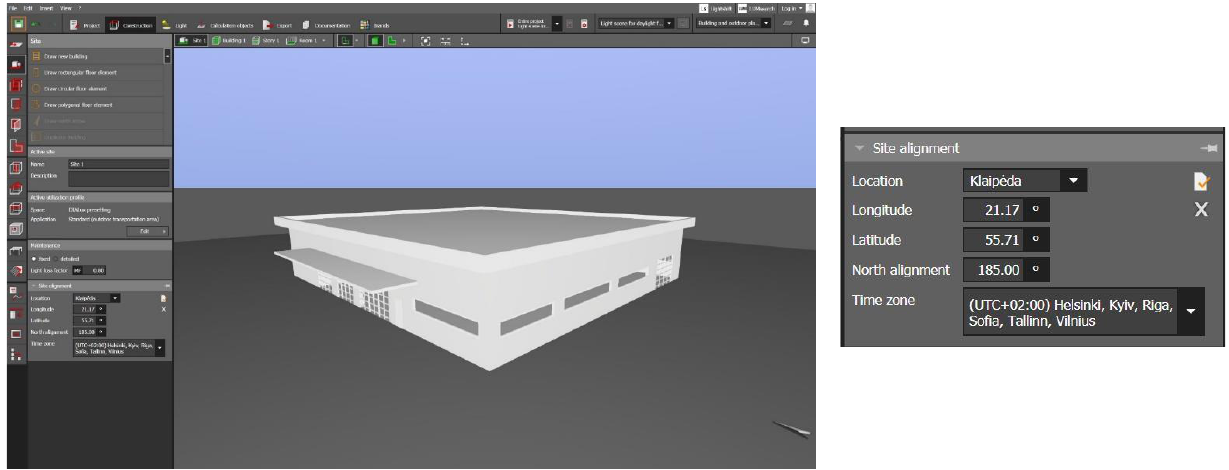
Figure 2. View of the building model developed by the DIAlux evo software and site alignment according to the exact location of the building.